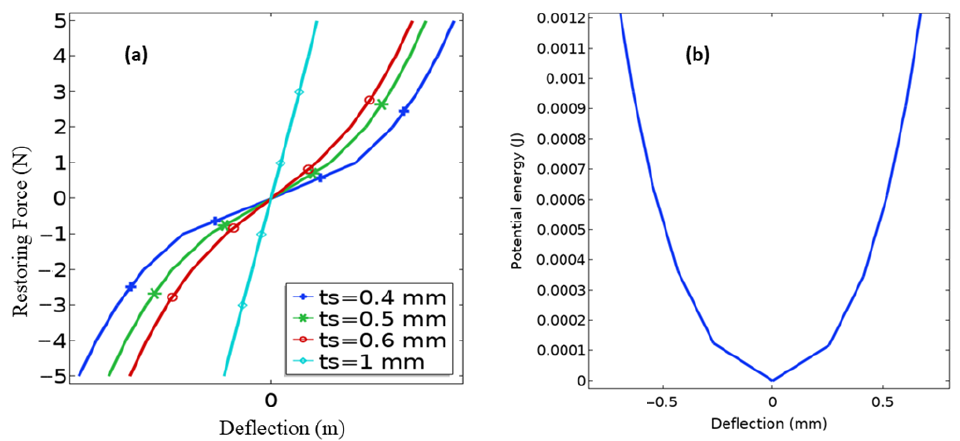
Figure 6. ( a ) The restoring force of spring vs. deflection amplitude corresponding to different spring thicknesses in the exsect-tapered PEH and ( b ) potential energy of the monostable PEH with a spring thickness ts = 0.5 mm.